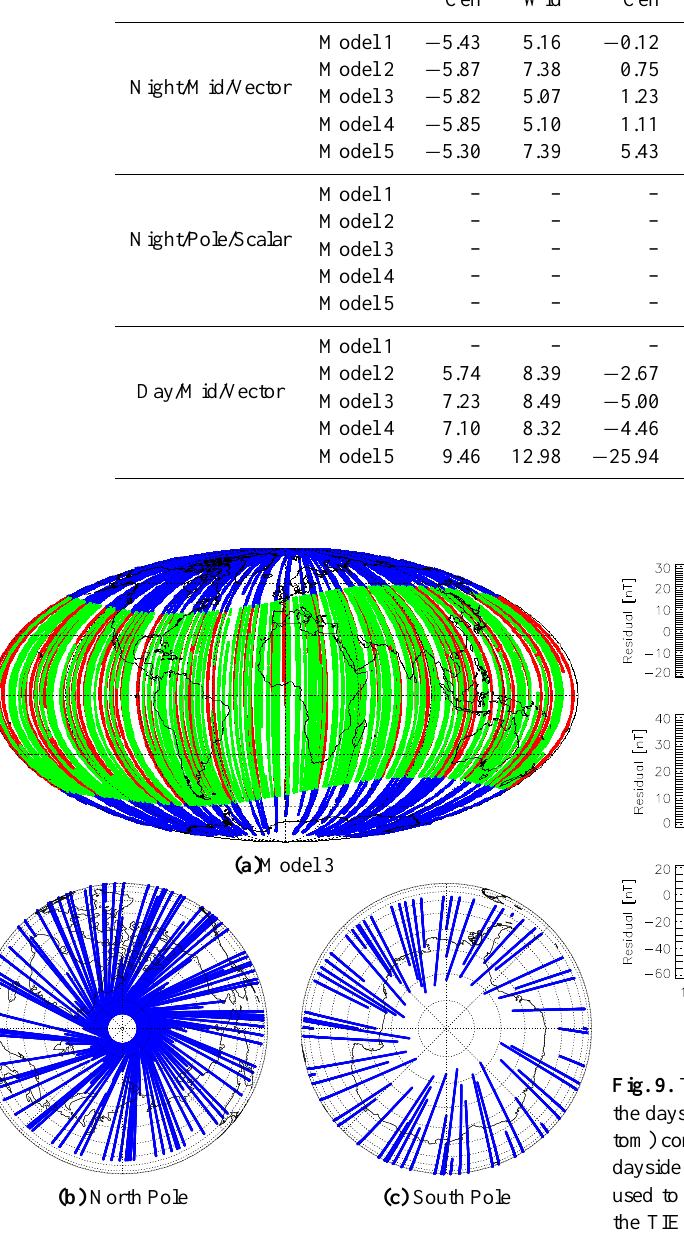
Fig. 8. Data distribution for Model 3 where red is CHAMP vector nightside, blue is CHAMP scalar nightside, and green is CHAMP vector dayside. Windows (b) and (c) show the scalar data distribu- tion in the polar regions and demonstrate, especially in the southern polar region, the problem of using such a short time span.